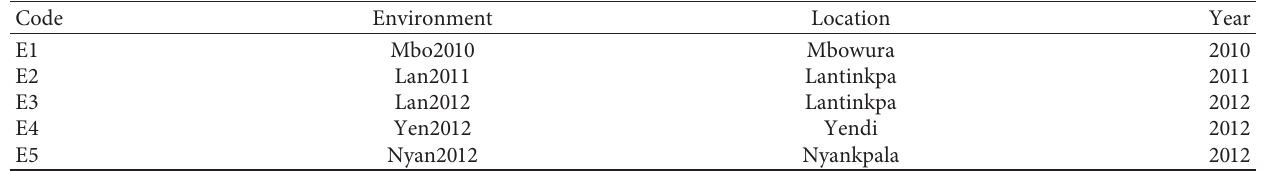
Table 2: List of environments used for the